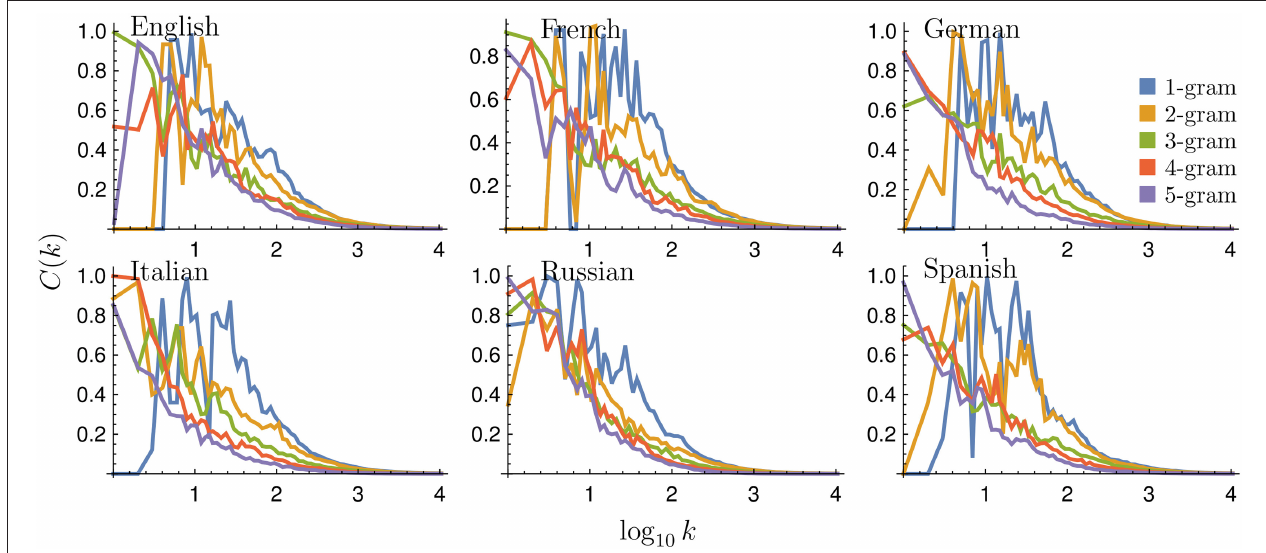
FIGURE 11 | Rank complexity for different languages and N -grams. Binned rank complexity C ( k ) as a function of rank k for all languages and N values considered. Rank complexity tends to be greater for lower N , as rank entropy increases with N .